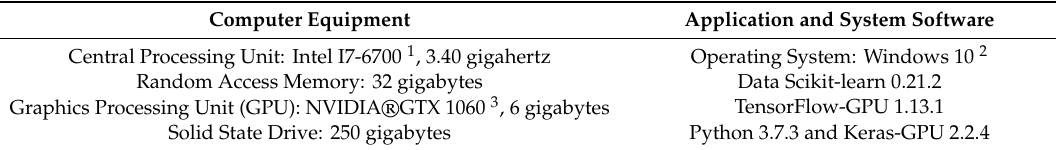
Table 1. The experimental